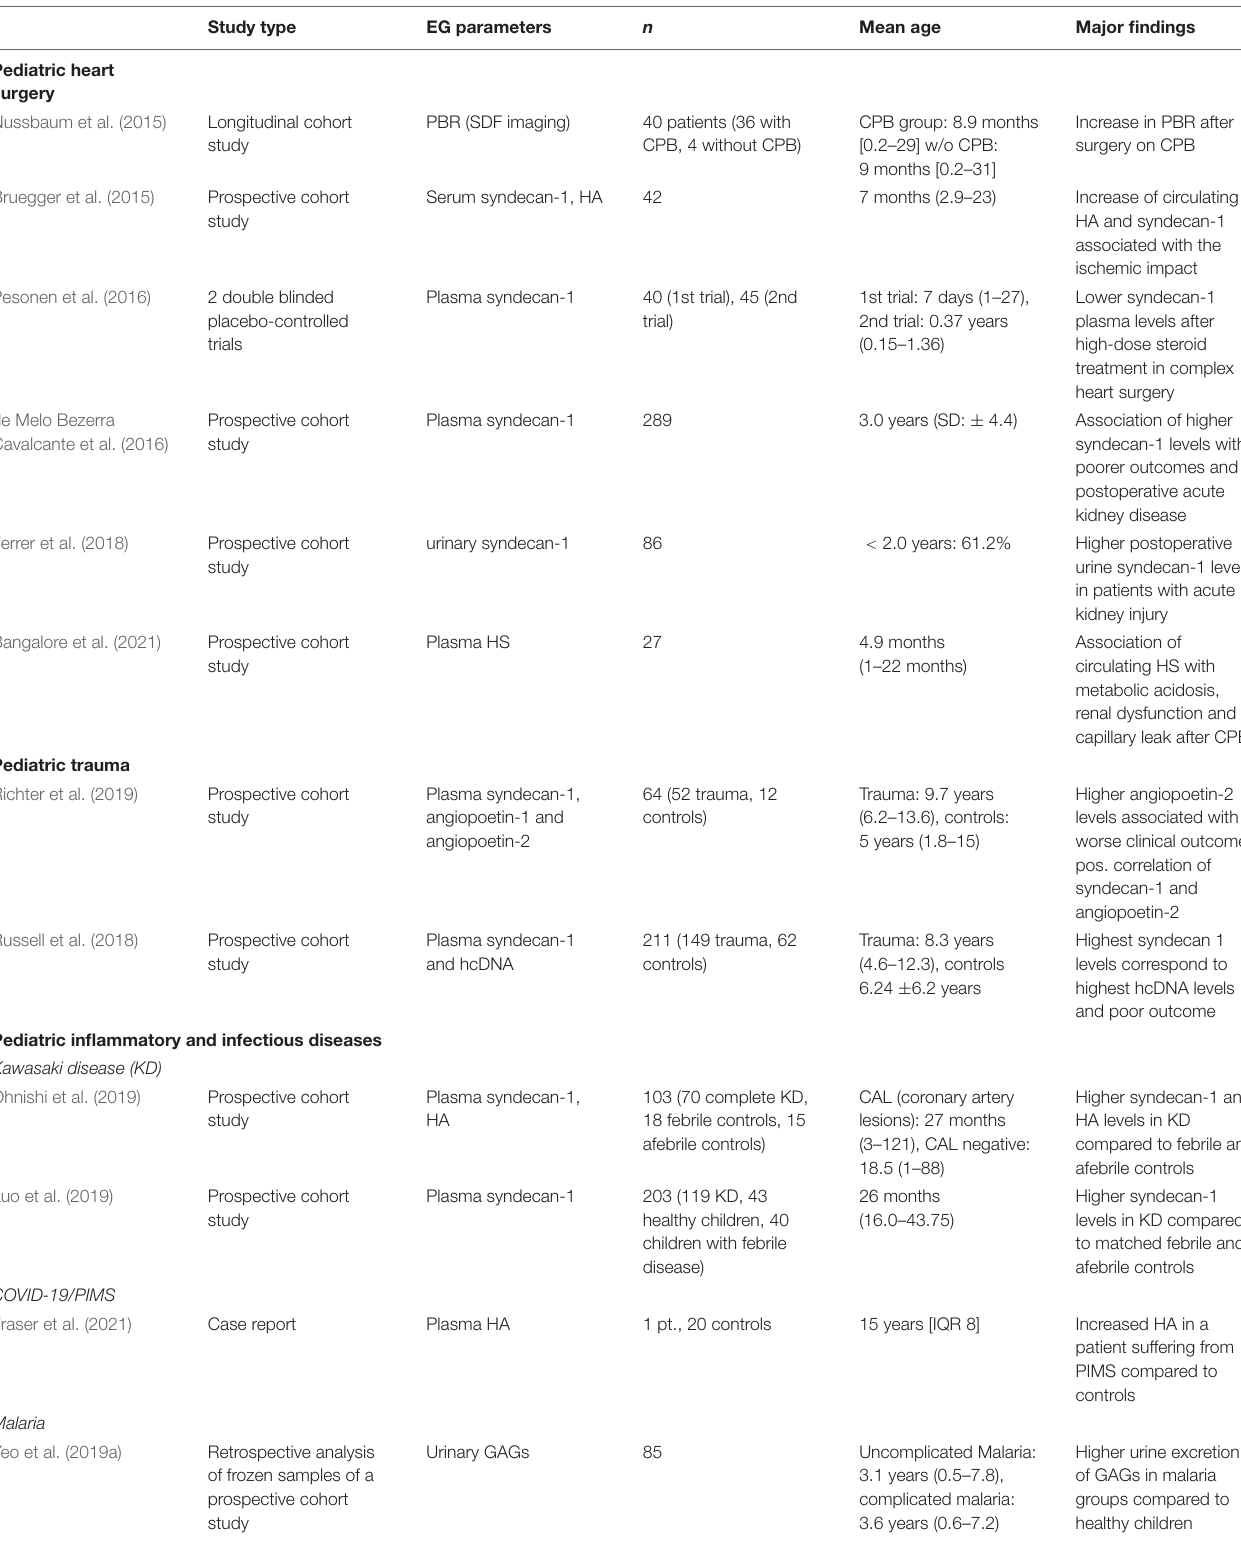
TABLE 1 | Clinical studies investigating the EG in the pediatric